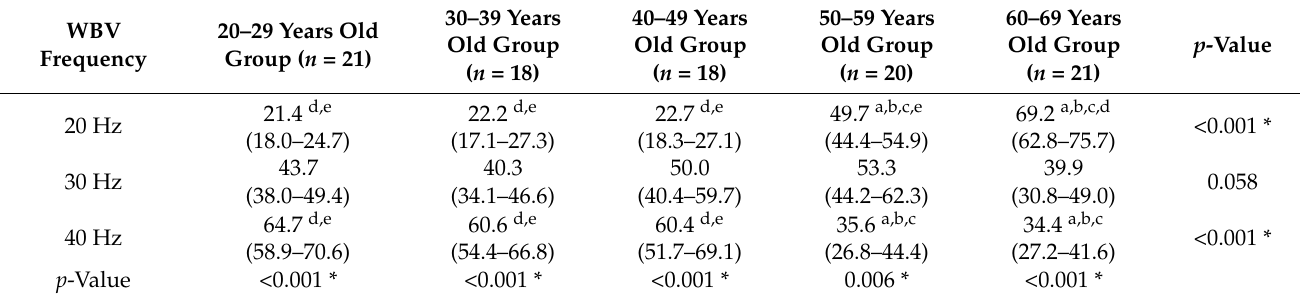
Table 2. The neuromuscular activation of the rectus femoris muscle during whole-body vibration training at different frequencies in different age